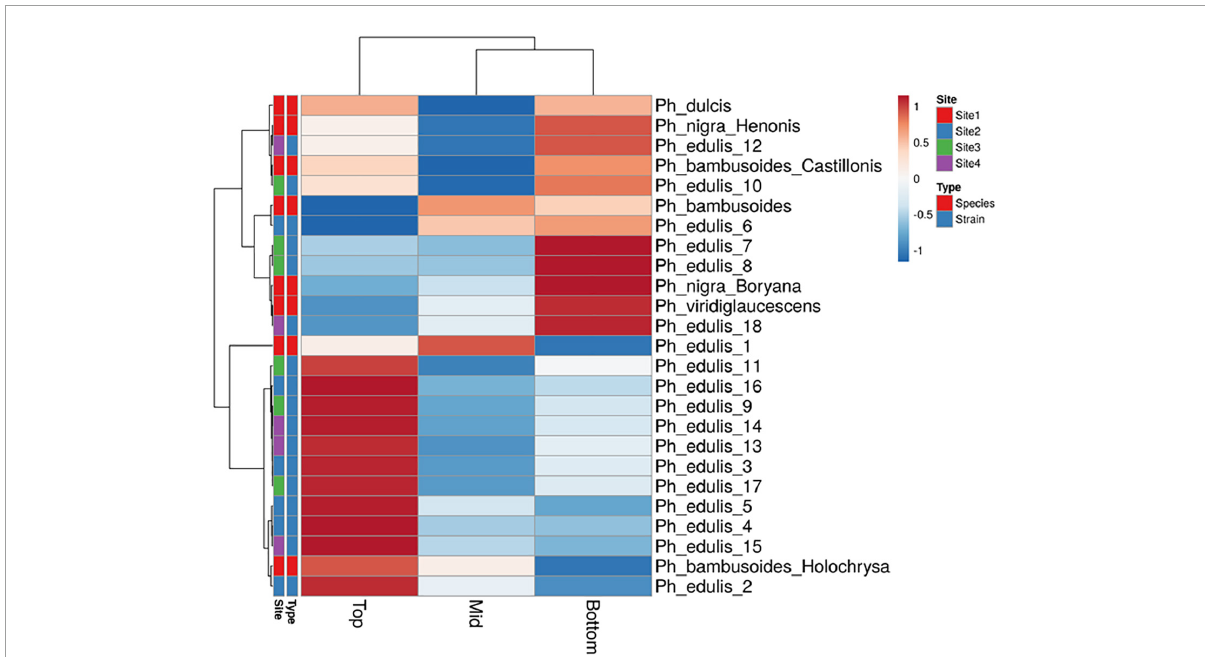
FIGURE6 Hierarchical cluster analysis (HCA) based on Pearson’s correlation and average linkage with heat map representation of splitting strength trait. Rows are centered; unit variance scaling is applied to rows.